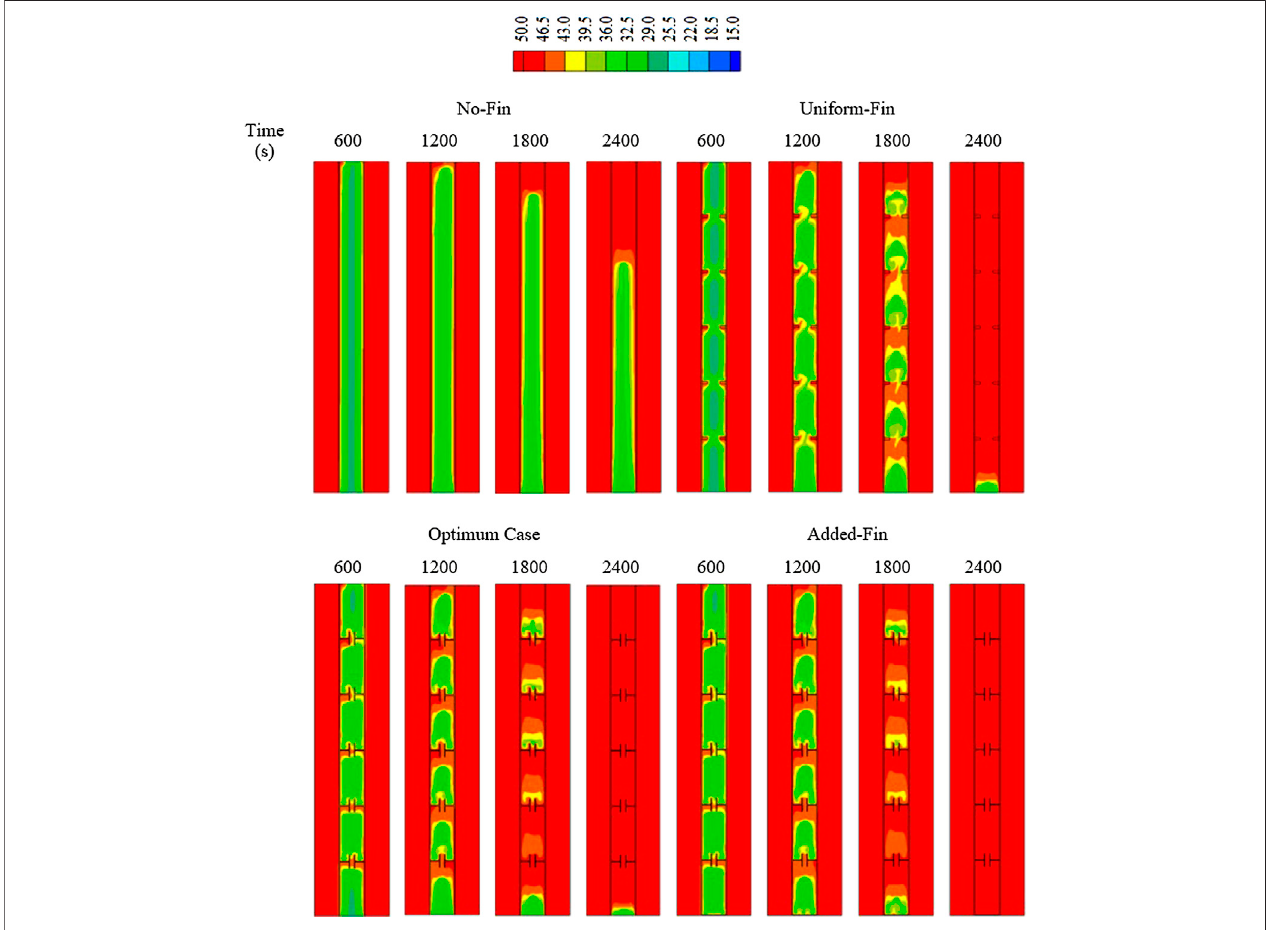
FIGURE 13 | Temperature distribution for various cases of No-Fin, Uniform-Fin, Optimum, and Added-Fin cases at various times.